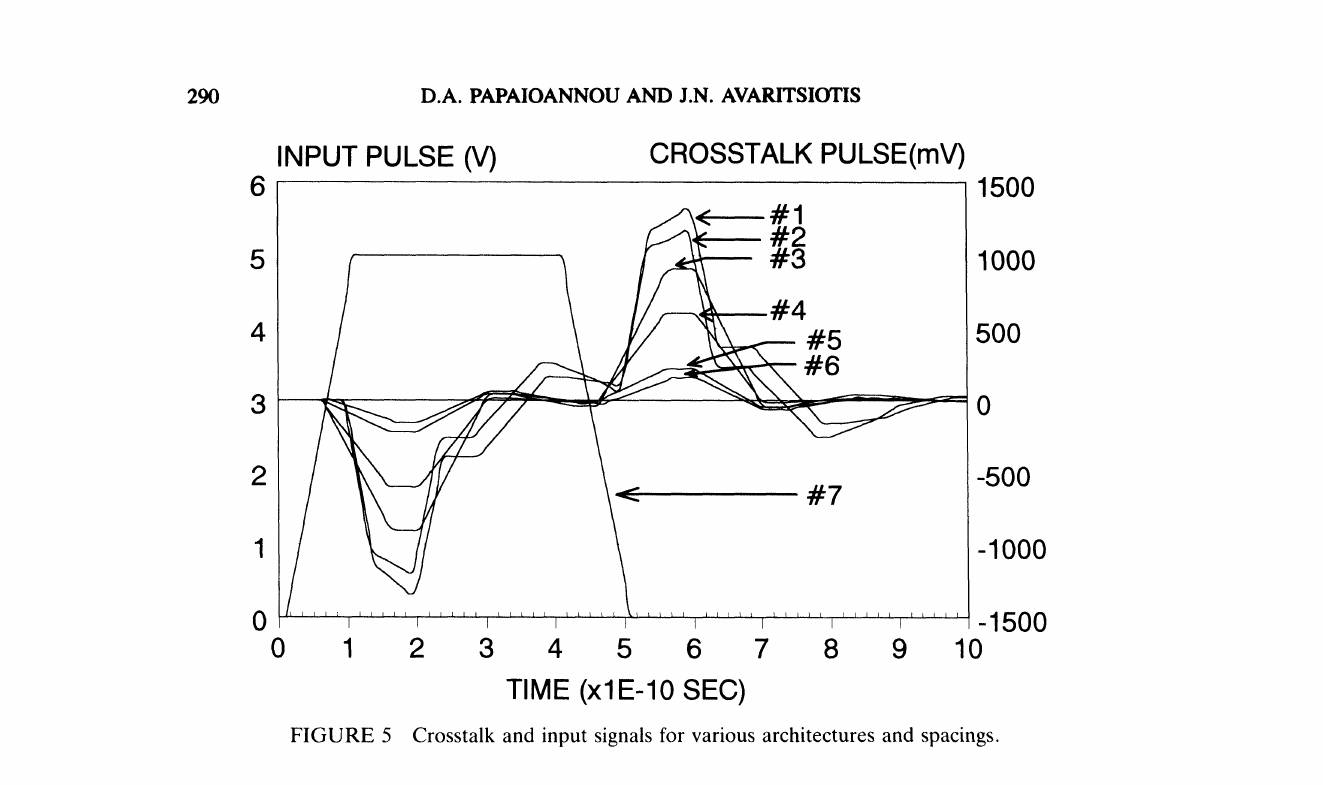
FIGURE 5 Crosstalk and input signals for various architectures and